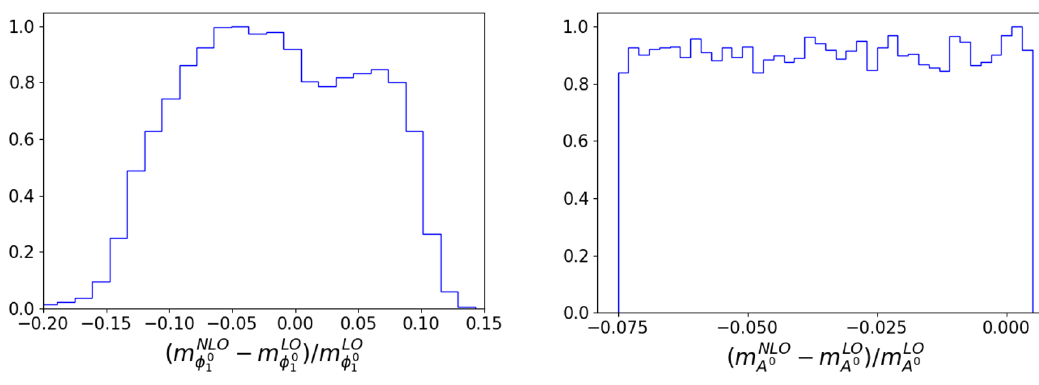
, right) obtained for the same parameter sample as in A